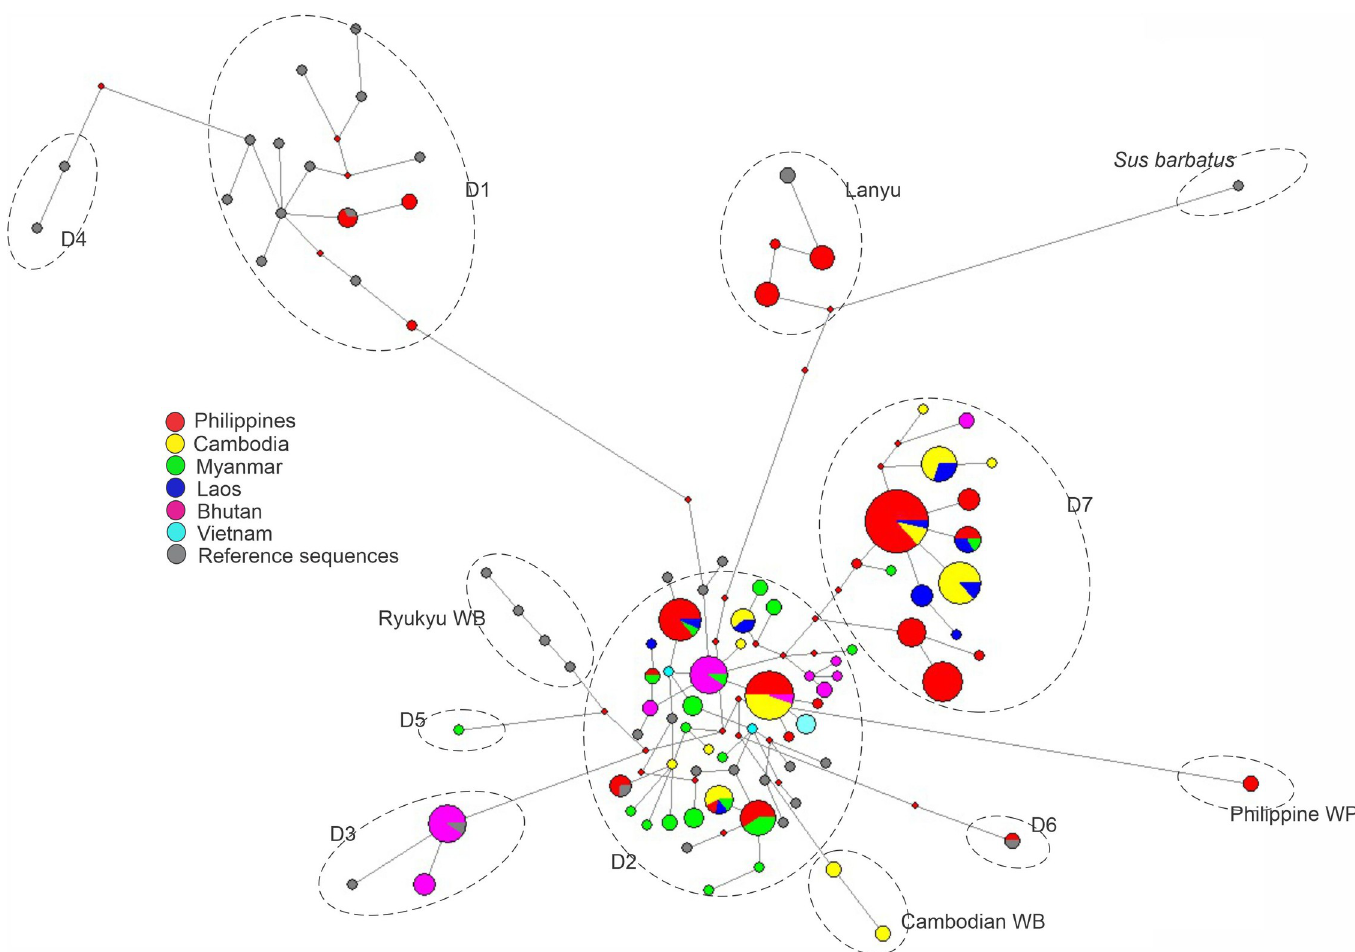
Fig 4. The median-joining network of Asian and European pig haplotypes including the global reference sequences showing haplogroup classification. Some haplotypes clustered together coinciding with their geographic area of origin, while selected haplotypes diverse and shared by individuals of different breeds from different geographical regions, indicating a negative correspondence between the geographic origin and the relationships among breeds. The size of each circle is proportional to the haplotype frequency. Color represents regions of sequence origin.